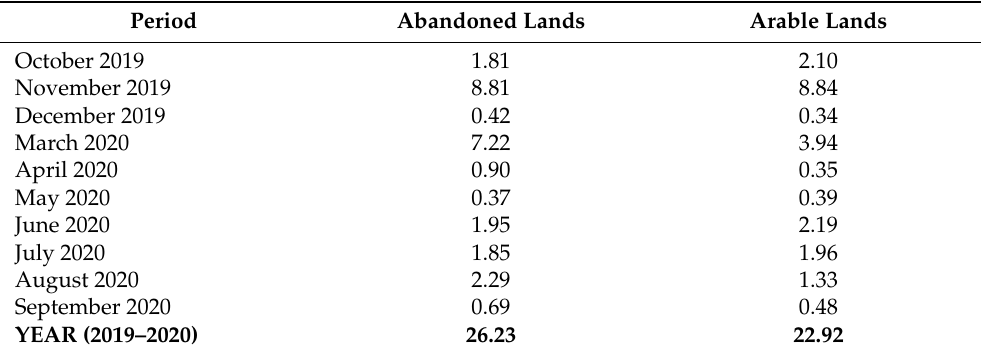
Table 2. Average monthly and annual RUSLE values (expressed in Mg-ha − 1 -year − 1 ) for arable and aban- doned lands .